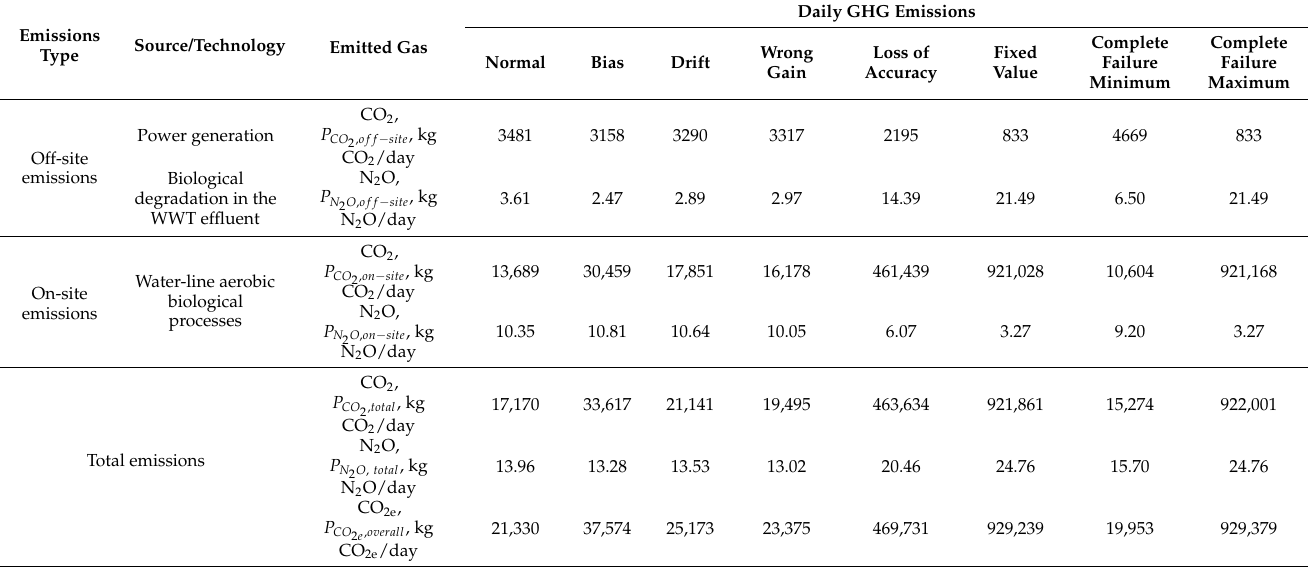
Table 5. GHG emissions due to DO sensor